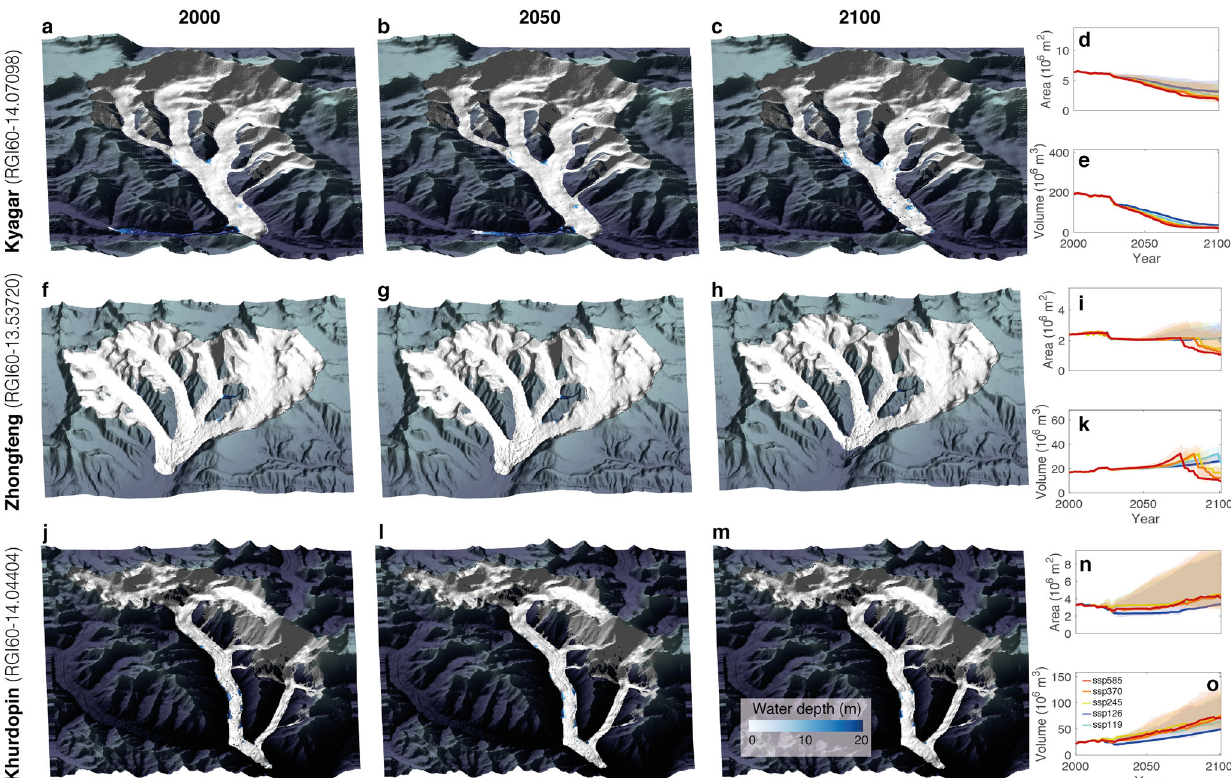
Fig. 4 Evolution of ice-dammed lakes for three selected glaciers. The modelled evolution of both the glacier geometry and the ice-dammed lakes is shown for ( a – c ) Kyagar, ( f – h ) Zhongfeng and ( j , l , m ) Khurdopin Glaciers. The columns refer to the years 2000, 2050 and 2100. The lake colour shows the lake depth with a scale given in ( m ). d , i , n Area and ( e , k , o ) volume evolution of all potential ice-dammed lakes for each glacier.